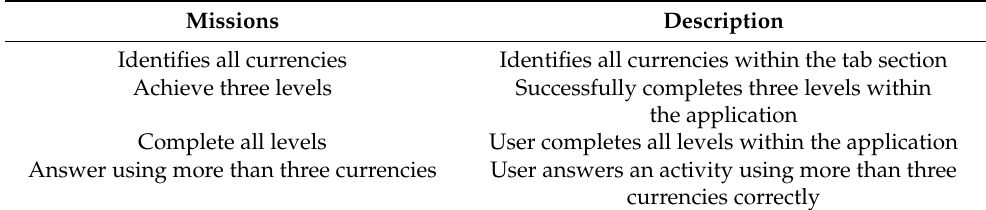
Table 3. Missions implemented in the “Learning with Pesos” game.